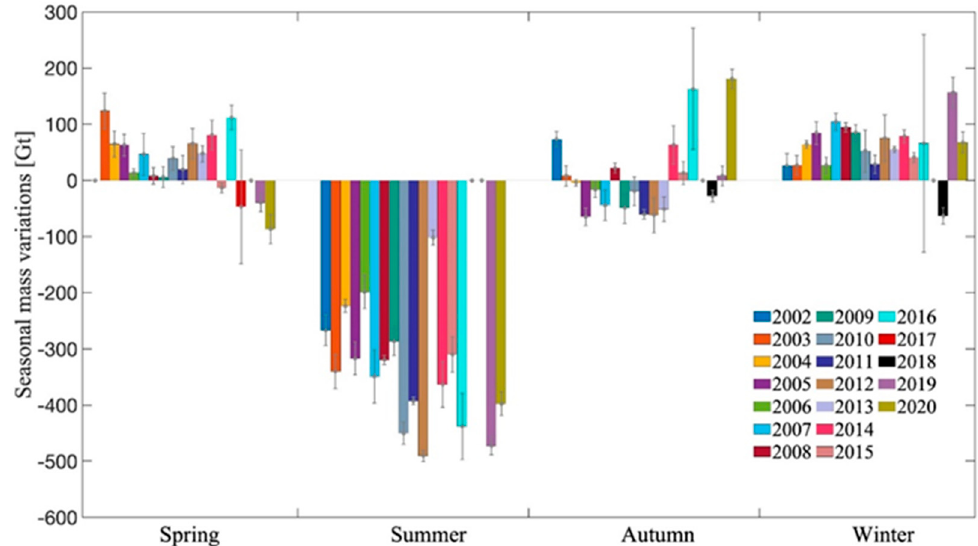
Figure 3. Seasonal mass variations of the GrIS derived from GRACE/GRACE-FO data during 2002–2020. As seasonal mass change consists of monthly mass gain, or monthly mass loss or both, here we attempted to partition mass change in each season into mass gain and mass